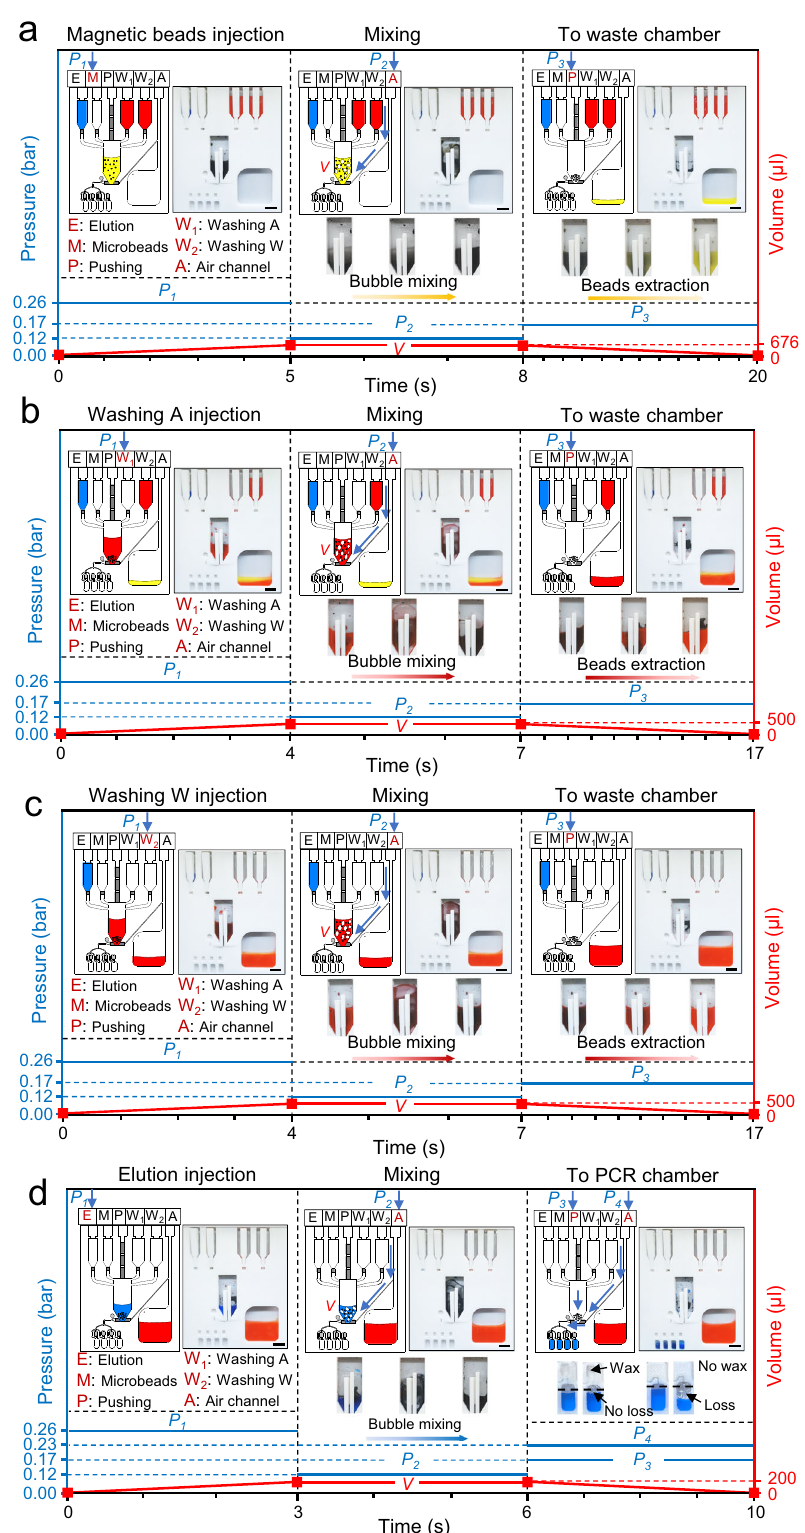
Fig. 4 | Illustration for working principle of FAST-POCT platform. a RNA adsorption step, the sample is introduced into the M inlet and injected into the mixing chamber together with the pre-stored microbeads solution. After mixing and beads extraction, the reagent is dispensed to the waste chamber. b , c Washing step, different pre-stored washing reagents are injected into the mixing chamber and after mixing and beads extraction, the reagents are transferred to the waste